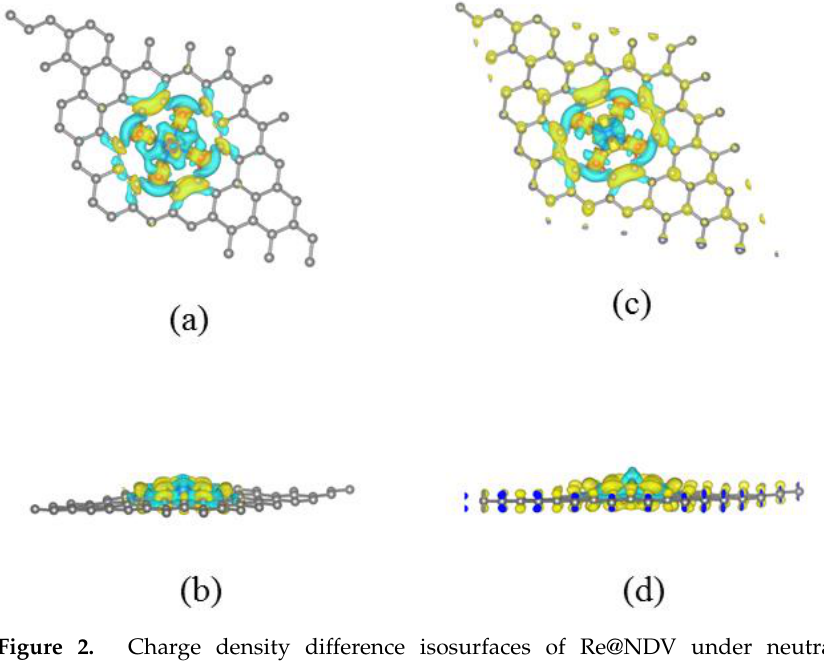
Figure 2. Charge density difference isosurfaces of Re@NDV under neutral and adding 0.2e/unit cell, respectively. ( a , c ) Top view; ( b , d ) side view. The yellow color represents charge accumulation, while the cyan color represents the charge depletion zone. ∆ρ = ρ(Re@NDV − Gr) − ρ(Re) − ρ(NDV − Gr) .